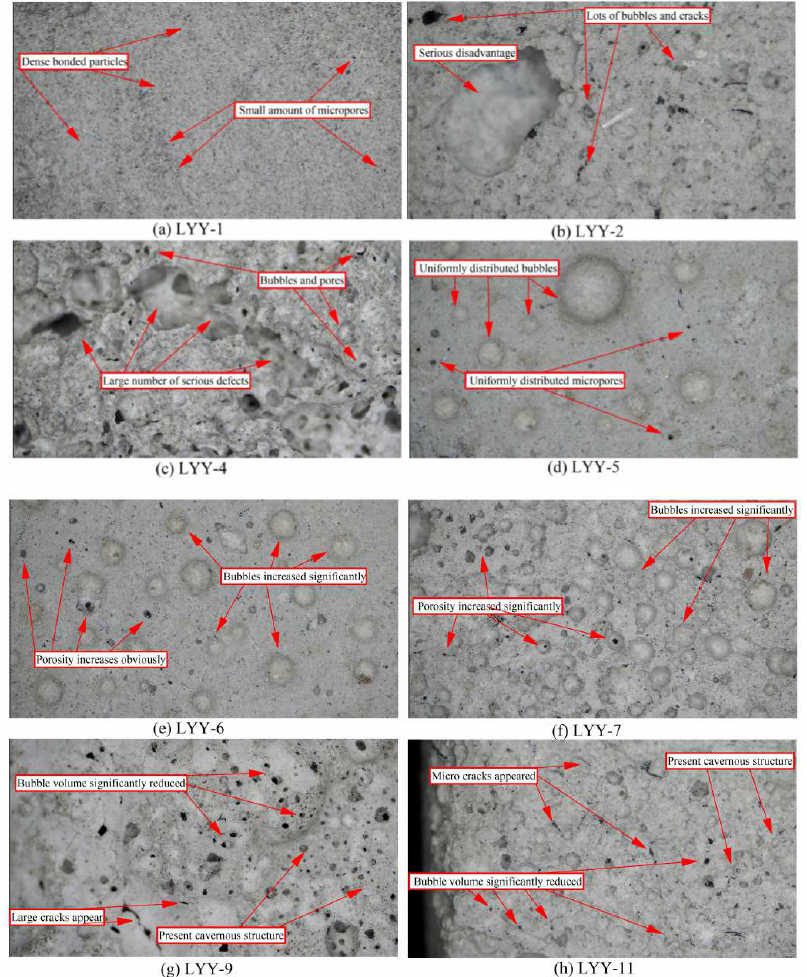
Figure 5. Microstructure of specimens